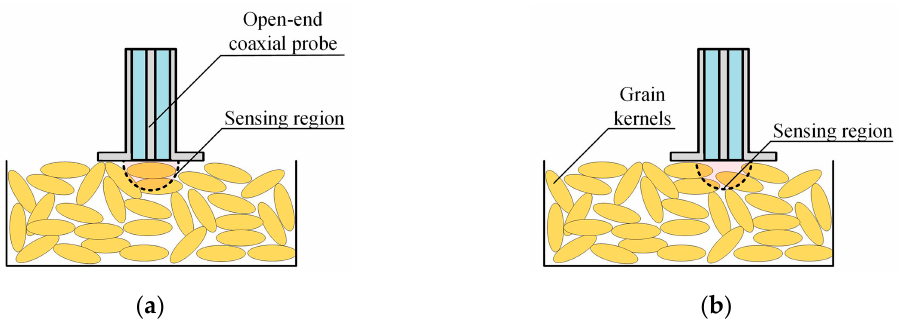
Figure 1. Schematic of the sensing region of an open-ended coaxial probe measuring grain samples: ( a ), the center of the probe connecting to a grain kernel; ( b ), the center of the probe connecting to pore among grain kernels.